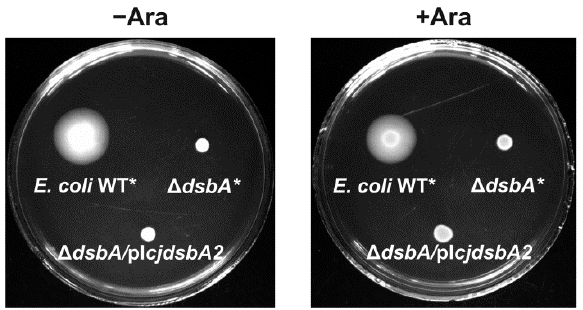
Figure 5. CjDsbA2 did not restore motility in dsbA -deficient E. coli strain. Exponentially growing E. coli JCB816 (wild-type) and JCB817 ( ∆ dsbA) both carrying pMPM-A6 plasmid (*), and ∆ dsbA /pl cjdsbA2 strain were spotted onto LB soft agar plates supplemented with 0.2% arabinose (+Ara) and incubated for 24 h at 37 ◦ C. As controls, we used plates without arabinose ( − Ara). Three independent experiments were performed ( n = 3). The figure presents a representative result.